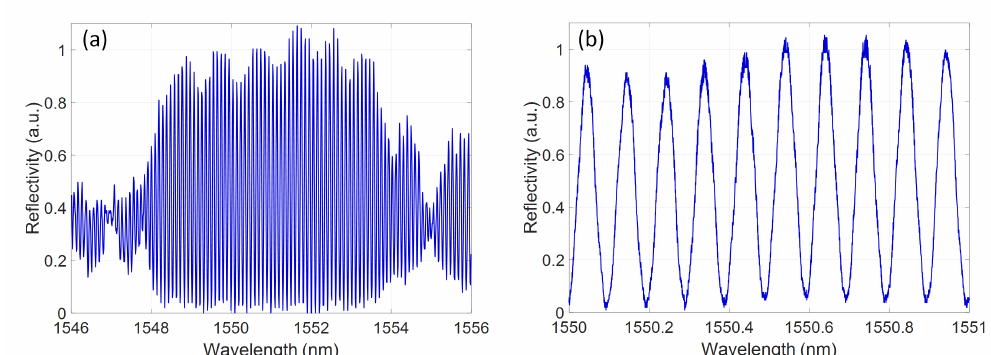
Figure 13. ( a ) Measured reflectivity spectrum of the grating with no induced chirp; and ( b ) detailed spectrum of the Fabry–Perot fringes created by the intereference between the device bar facet and grating